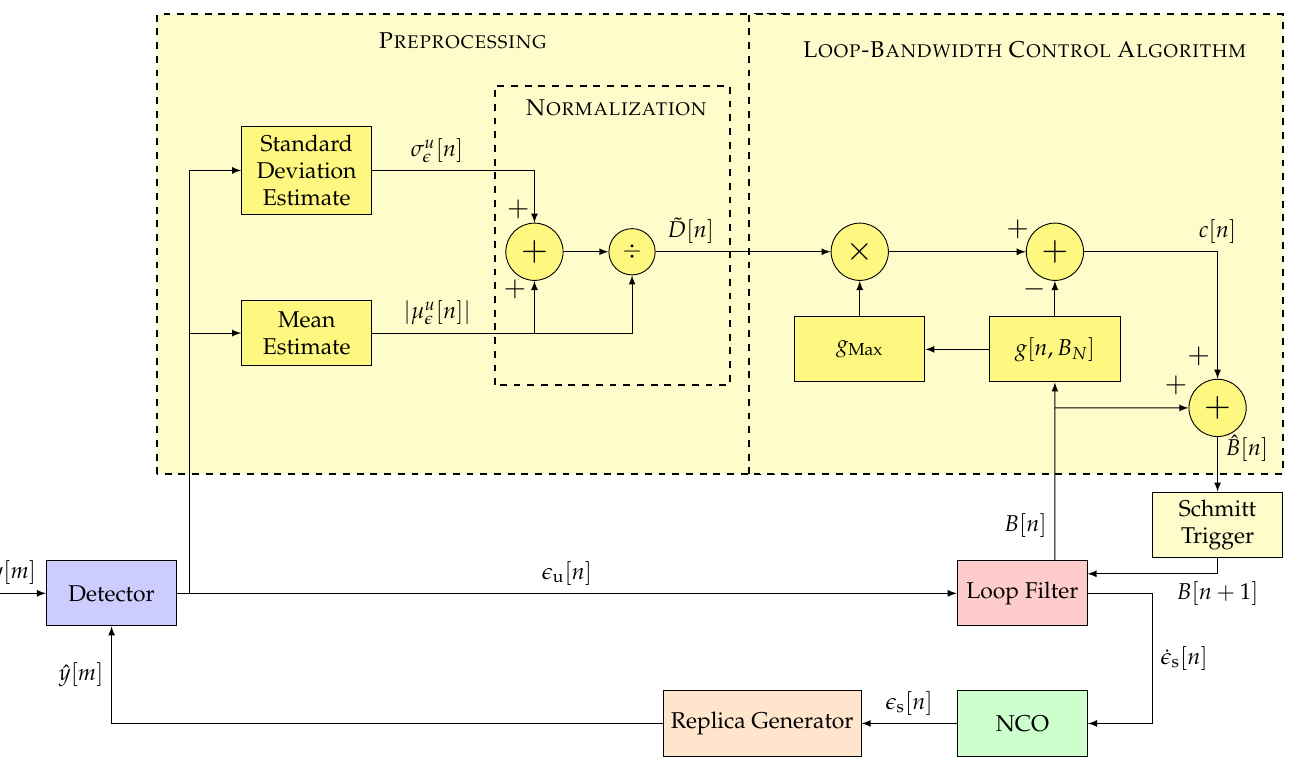
Figure 9. Architecture of loop-bandwidth control algorithm (LBCA). ©IEEE. Adapted, with permission, from